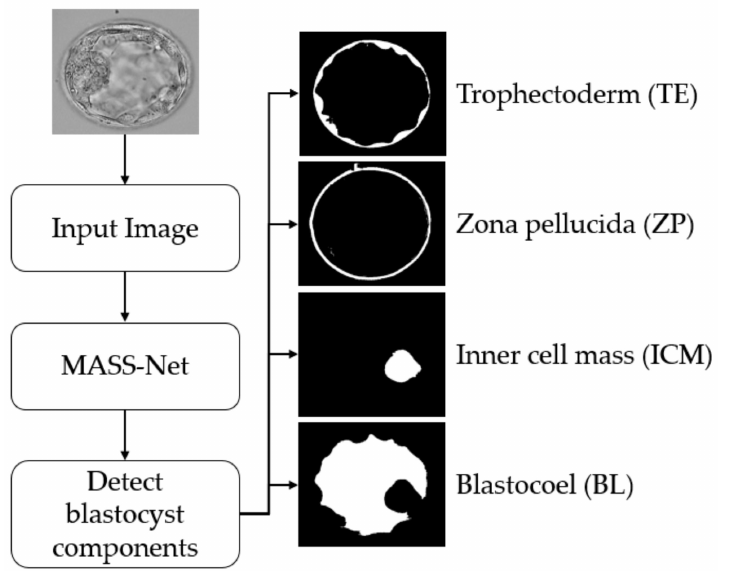
Figure 2. Summarized workflow of the proposed method (MASS-Net) for embryo component segmentation for embryonic analysis. Abbreviation: MASS-Net, multiscale aggregation semantic segmentation